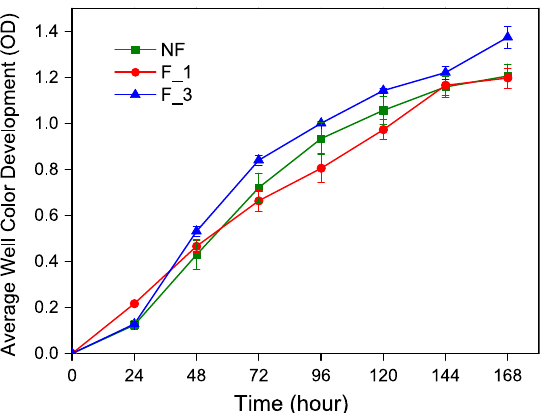
Fig. 7 Kinetics of the average well color development (AWCD 590 nm ) curve of bacterial communities of different fumigation years (mean SE, n 3). NF non-fumigation, F_1 chloropicrin-fumigation ± = for 1 year, F_3 continuous chloropicrin-fumigation for 3 years